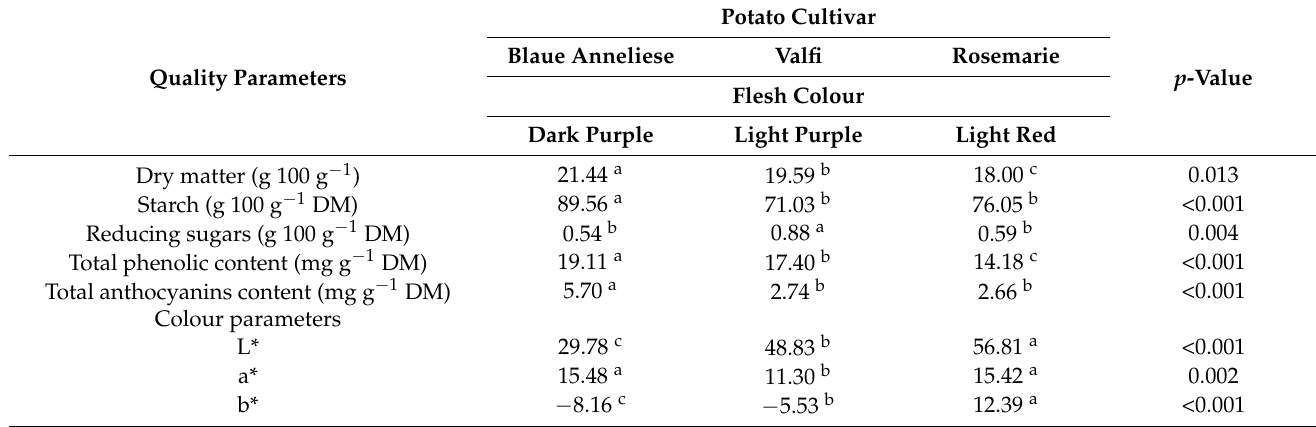
Table 2. The proximate composition and colour parameters of raw potato tubers with coloured